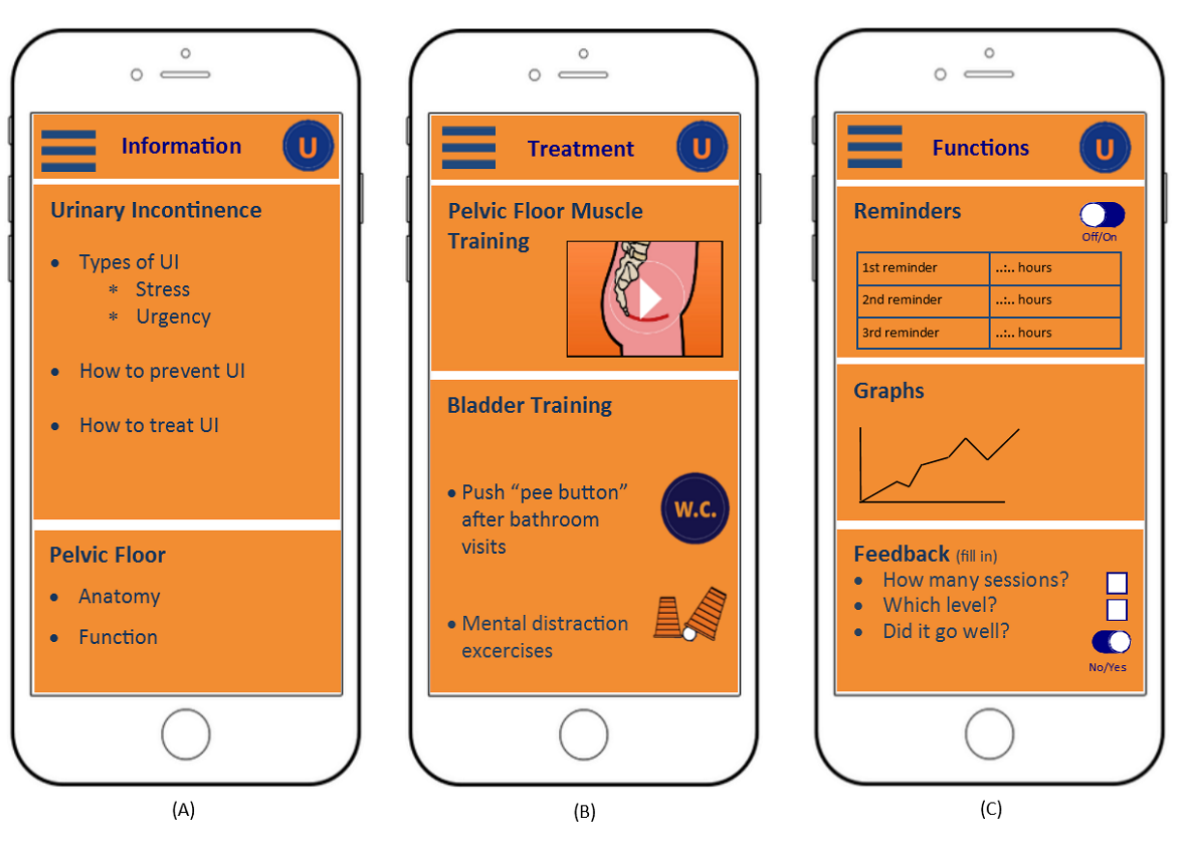
Figure 1. Representation of the contents of the URinControl app. (A) Information on both types of urinary incontinence, prevention and treatment options, as well as information on the anatomy and function of the pelvic floor. (B) Training programs for both stress and urgency urinary incontinence. (C) Functionalities of the app, including three reminder options, the graph function, and a patient feedback option. UI: urinary incontinence; W.C.: water